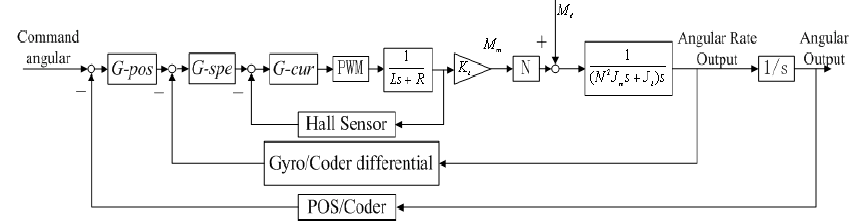
Figure 6. Block diagram of three-loop compound PID control structure of two-axis ISP control system in APLI system.